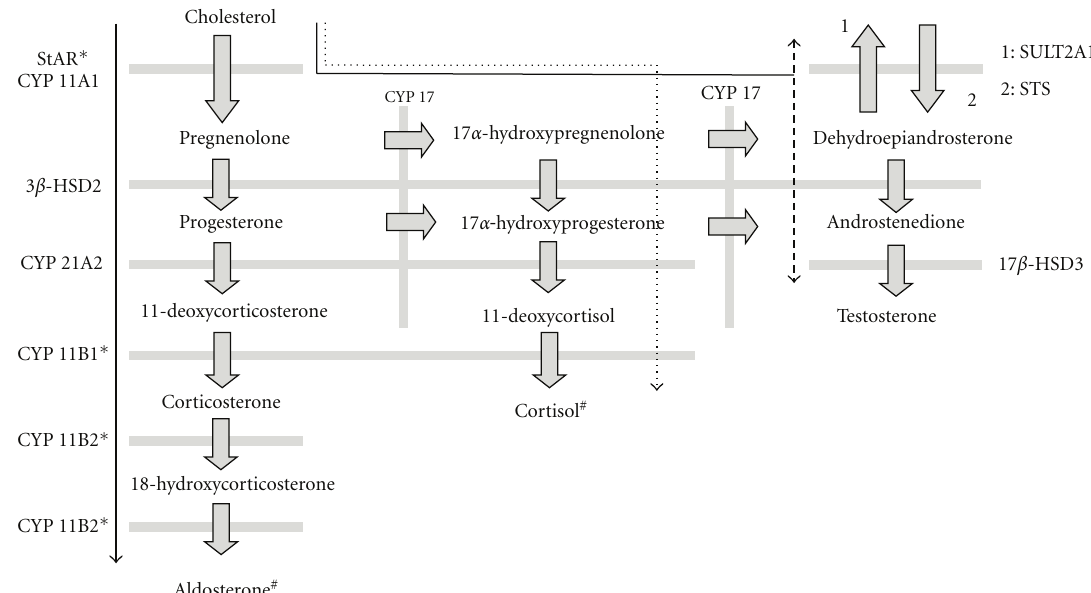
Figure 1: Overview of steroid biosynthesis in adrenal cells. Asterisks ( ∗ ) and the symbol ( # ) indicate enzymes and the adrenal steroid that may be modulated by dihydropyridine CCBs. Solid line: steroid biosynthesis in cells of the zona glomerulosa; dotted line: steroid biosynthesis in cells of the zona fasciculate; broken line: steroid biosynthesis in cells of the zona